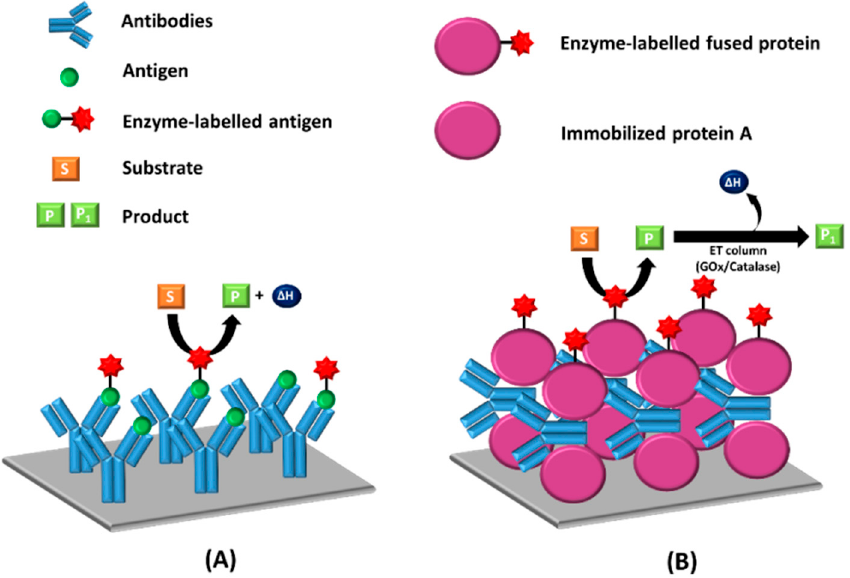
Figure 9. Schematic representation of the thermometric enzyme-linked immunosorbent assay (TELISA) method. ( A ) Direct competitive TELISA; ( B ) sandwich TELISA. Adapted from [124].